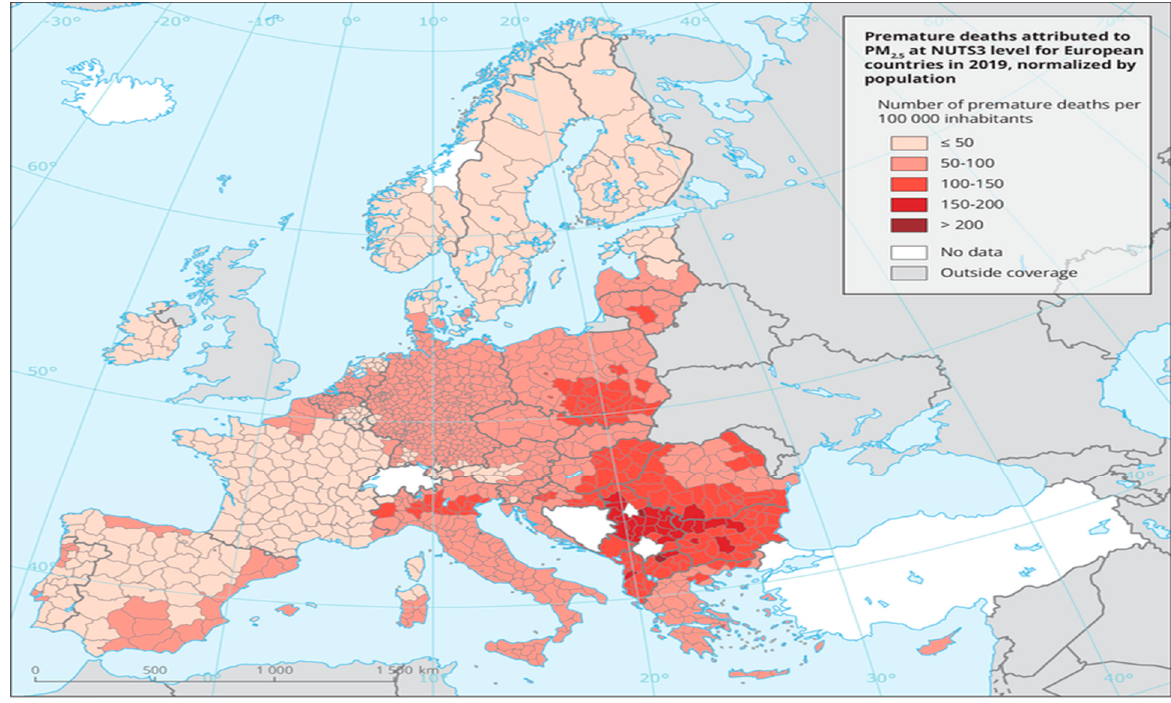
Figure 2. The number of premature deaths attributed to PM 2.5 in 2019 was normalized by population (Copyright holder: European Environment Agency (EEA), published 15 December 2021).